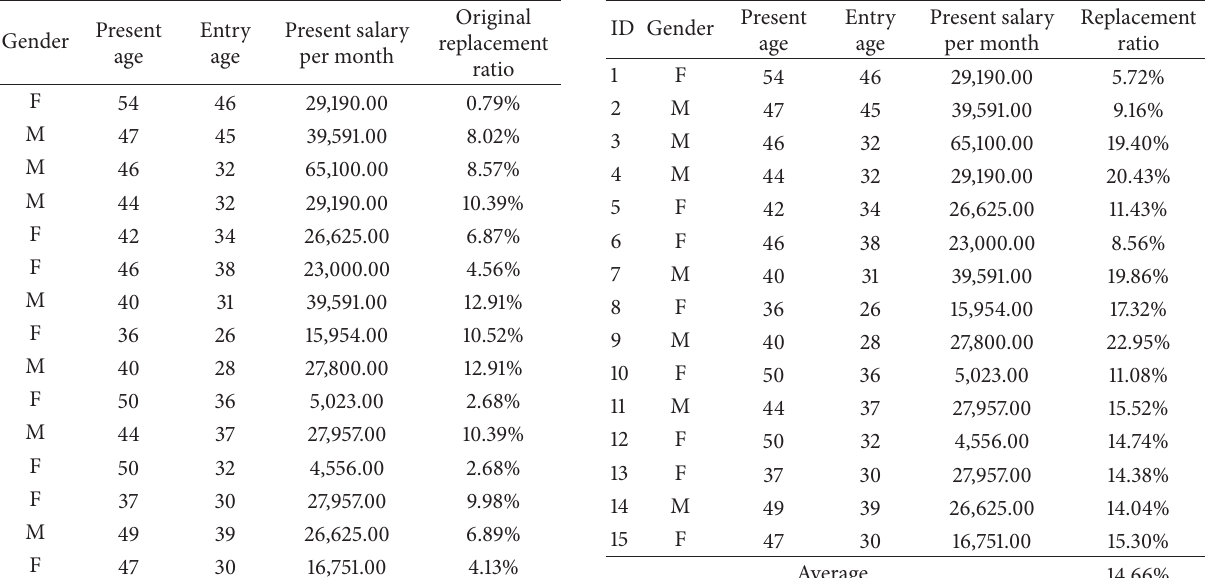
Table 5: Replacement ratio for original defined contribution pen- sion plan.